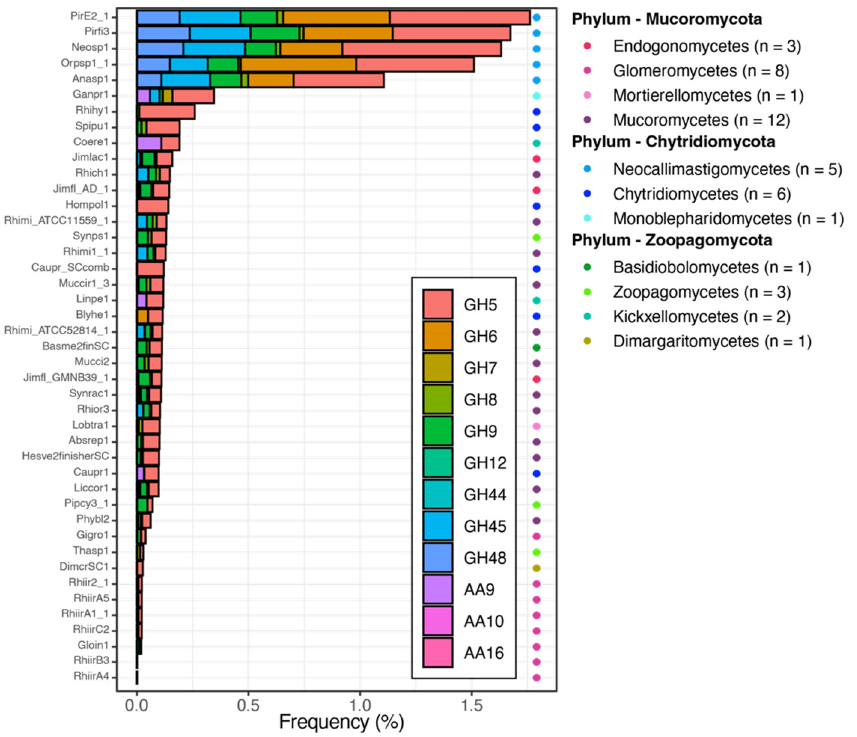
Figure 6. Frequency of the predicted potential cellulases across genomes of the less abundant fungal phyla.